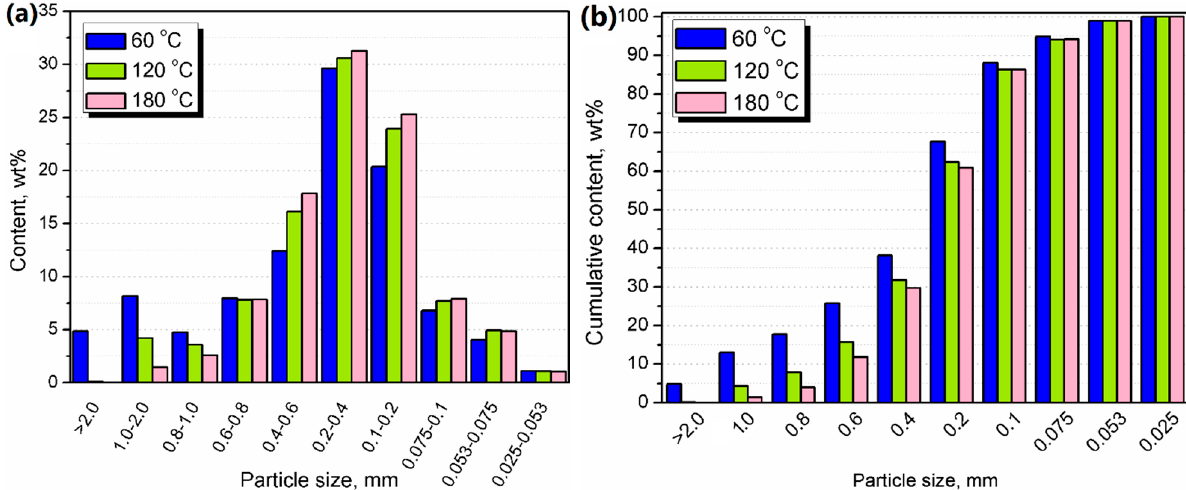
Figure 3. Graphs showing ( a ) content of particular fractions, and ( b ) cumulative particle size distribution of modified BSG samples.